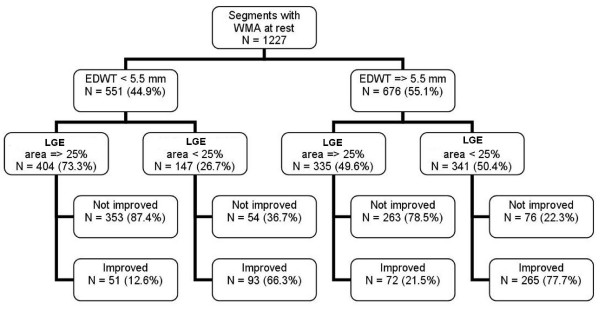
Diagram of the prediction of wall motion improvement by EDWT and LGE area (WMA = wall motion abnormality).